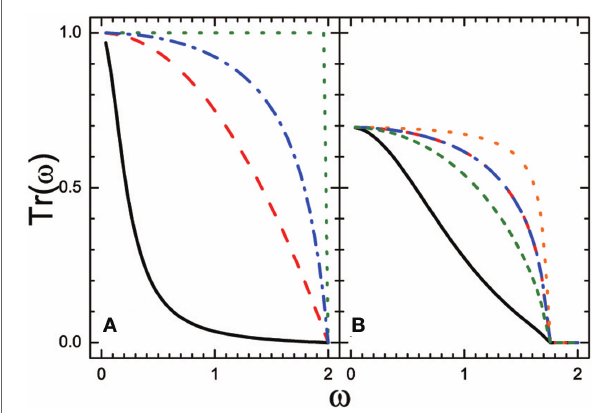
FIGURE 2 | Transmission coefficient Tr [ ω ] as a function of frequency ω for different interfacial coupling k 12 in single-junction model, adapted with permission from the copyright holder (American Physical Society), Zhang et al. (2011). (A) k L = k R = 1.0, m L = m R = 1.0; dash-dotted, dotted, dashed, and solid lines correspond to k 12 = 2.0,1.0,0.5,0.1. (B) k L = 1.0, m L = 1.0, k R = 3.0, and m R = 4.0; shot-dashed, dash-dotted, dotted, long-dashed, and solid lines correspond to k 12 =